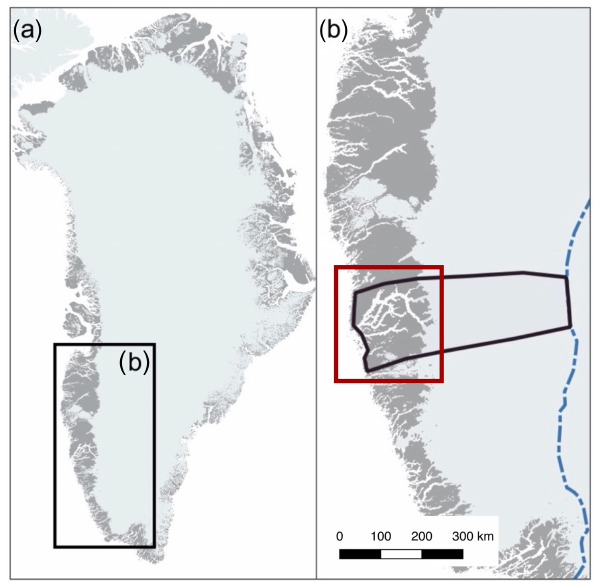
Figure 1. (a) The Greenland Ice Sheet. Highlighted is southwestern Greenland, where the ice model domain resides. (b) Southwestern Greenland. The ice model domain is outlined (bold black line), ex- tending between the present-day coastline and ice divide (dashed blue line; Rignot and Mouginot, 2012). The red box corresponds to the area in Figs. 5, 6, and